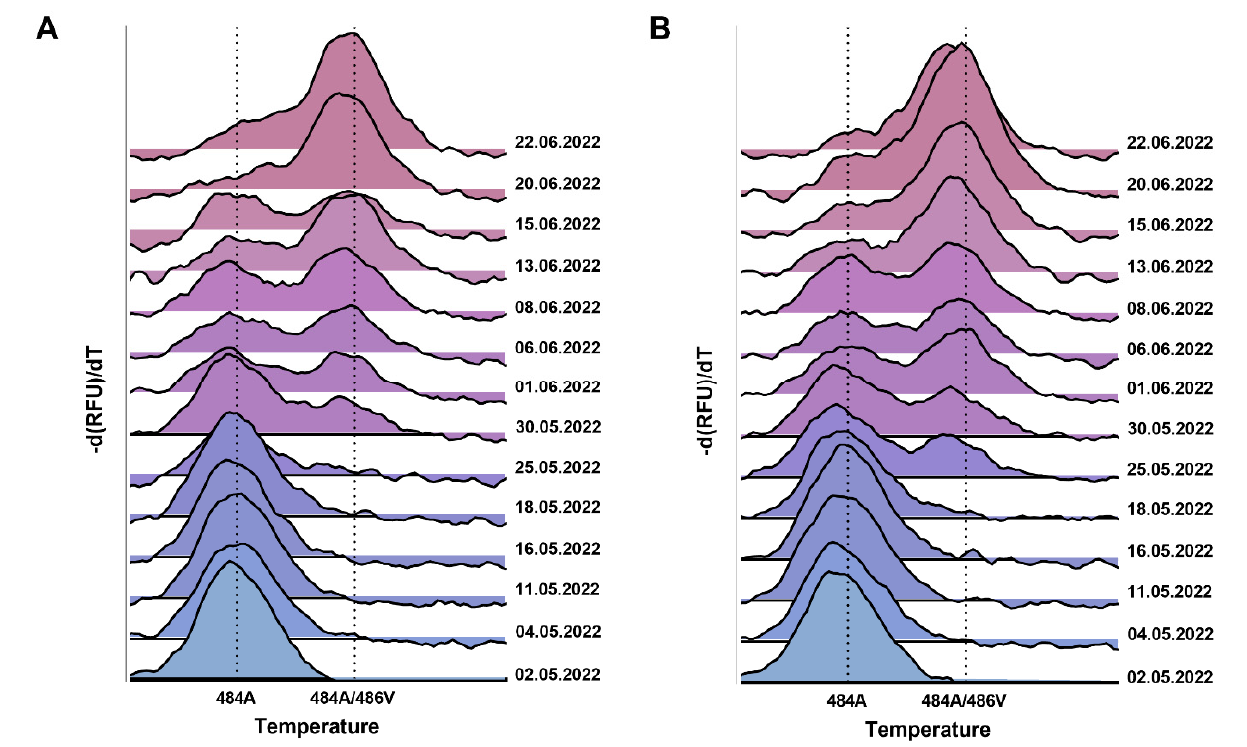
Figure 3. Confirmation of E484A/F486V substitution by melting curve PCR analysis. A variant-specific single nucleotide polymorphism PCR (SNP-PCR) targeting E484A/F486V was performed using RNA derived from the two WWTPs ( A ) KLEM and ( B ) DoD. The peak on the left (E484A) shows the specific melting temperature of an amplicon containing E484A, representing non-BA.4/BA5 SARS- CoV-2 RNA. Due to the low binding caused by mismatch, a lower temperature is required compared to E484A/F486V with a more efficient probe match. The color scheme is for orientation only and does not correlate with the proportion of the